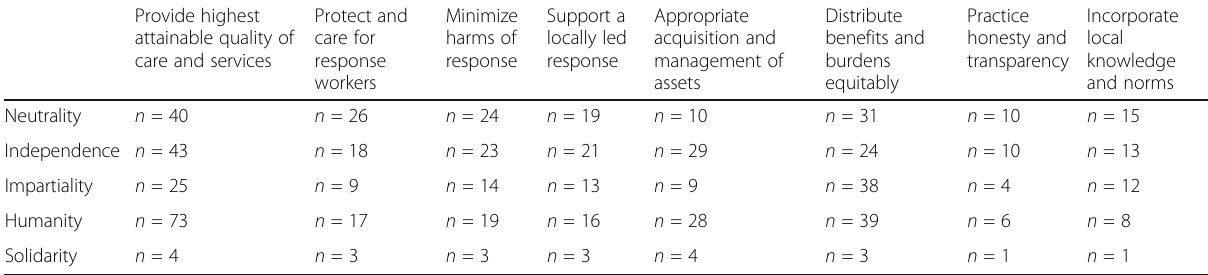
Table 3 Intersections between ethical obligations and humanitarian principles Provide highest attainable quality